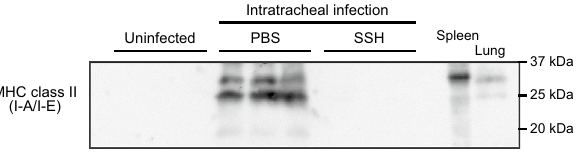
Figure 5. Murine MHC class II fragments are detectable in cell-free bronchoalveolar lavage fluid (BALF) from a mouse model of pneumococcal intratracheal infection. BALB/c mice (n = 7) were intratracheally infected with Streptococcus pneumoniae D39 (2 × 10 8 colony forming units in 50 µL PBS). Uninfected mice were administered PBS only. Neutrophil elastase (NE) inhibitor (sivelestat sodium hydrate (SSH) group; 50 mg/kg) or PBS (PBS group) was administered intraperitoneally into the infected mice every 6 h. MHC class II (I-A/I-E) levels in the cell-free BALF were determined by Western blotting. Murine spleen and lung tissue lysate from uninfected mice were included as controls. A representative Western blot image (three samples in each group) is